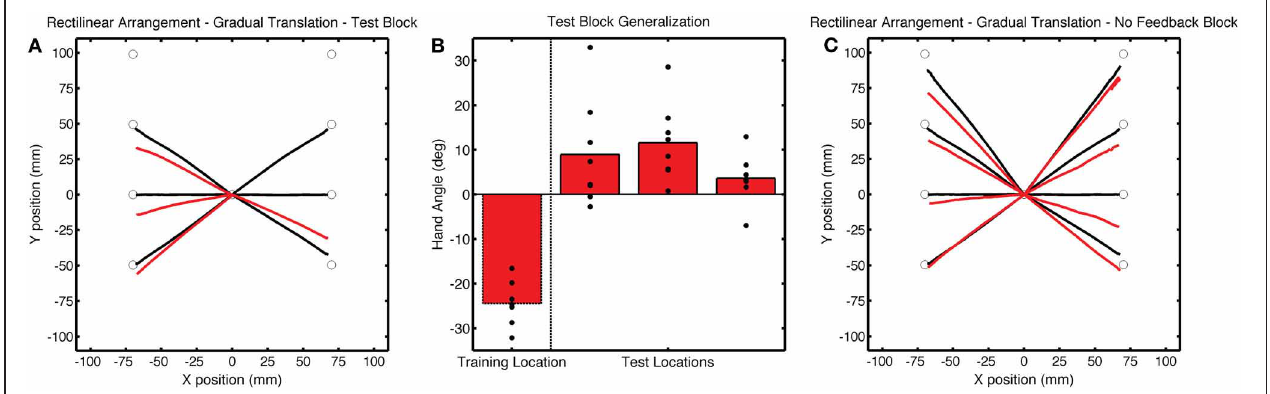
represent the values for each participant. (C) Average trajectories during the No Feedback block. Black lines in (A) and (C) correspond to average trajectories during the last baseline